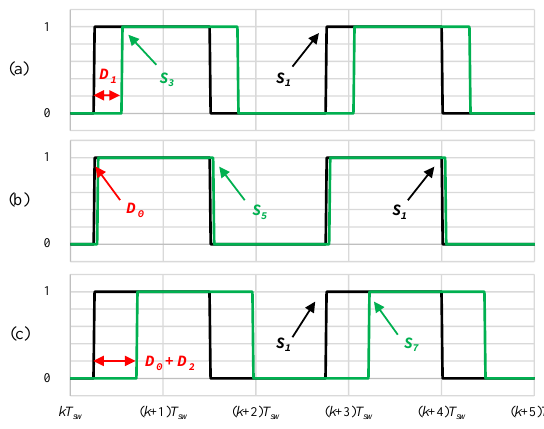
Figure 17. Triggering gate signals using TPS